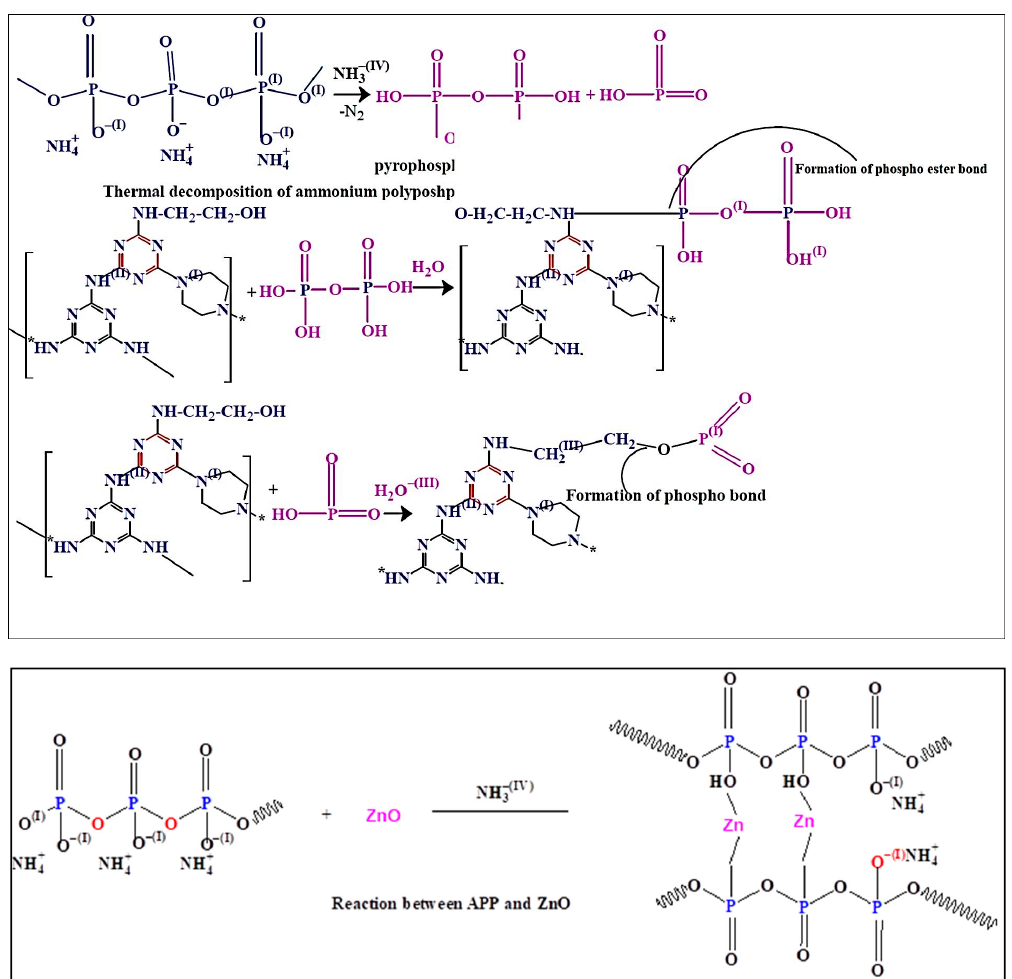
Figure 10. TGA results of the pure epoxy, Ep/IFR, and Ep/IFR/ZnO-3% samples.